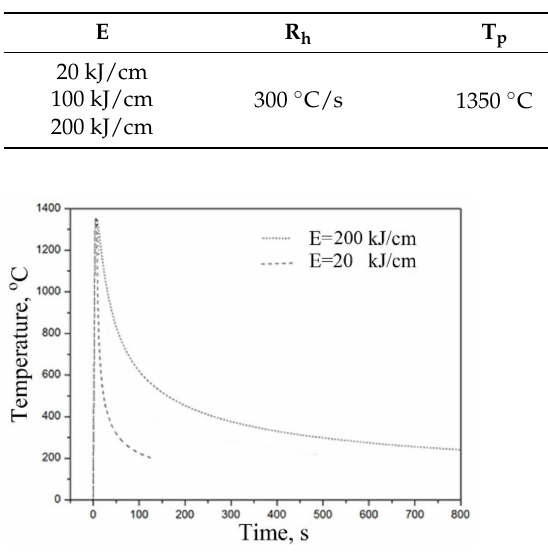
Table 2. Welding simulation parameters.